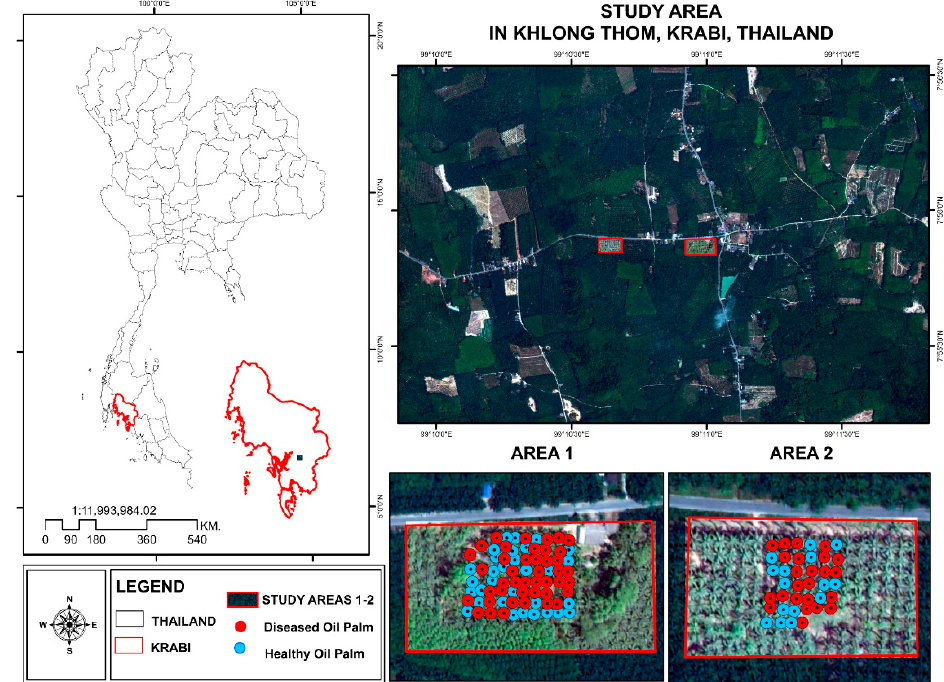
Figure 1. Geographical location and map of the study area in Khlong Thom-Tai district, Krabi province, Thailand. Areas 1 and 2 are the sampling areas and contain both healthy and diseases oil palm trees.